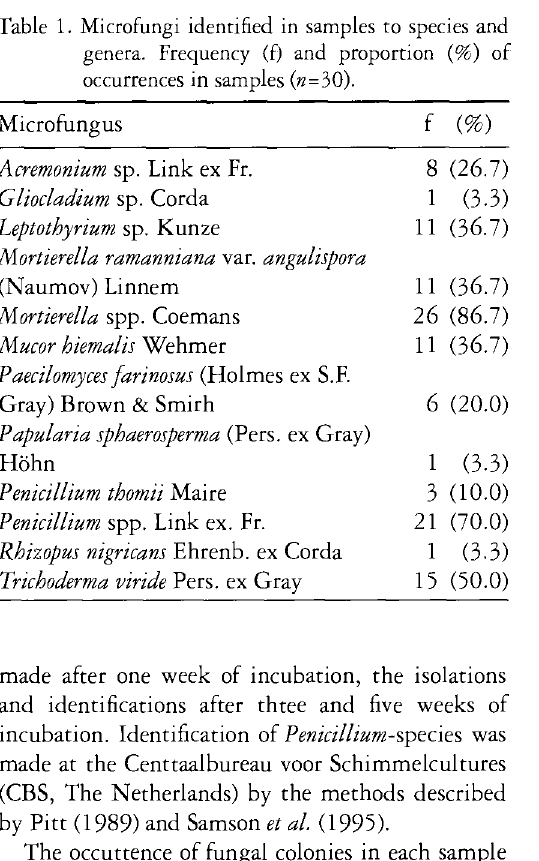
Table 2. The average number (median) of germinated fungal colonies in plant sample groups. A and B groups were col lected from ground vegetation with different temperatures on soil surface under the snow in winter and C gtoup just after snow-melting in spring. Microfungi were grown in four different nutrient media. The proba bilities of differences between the groups are prestented using Kruskall-Wallis'